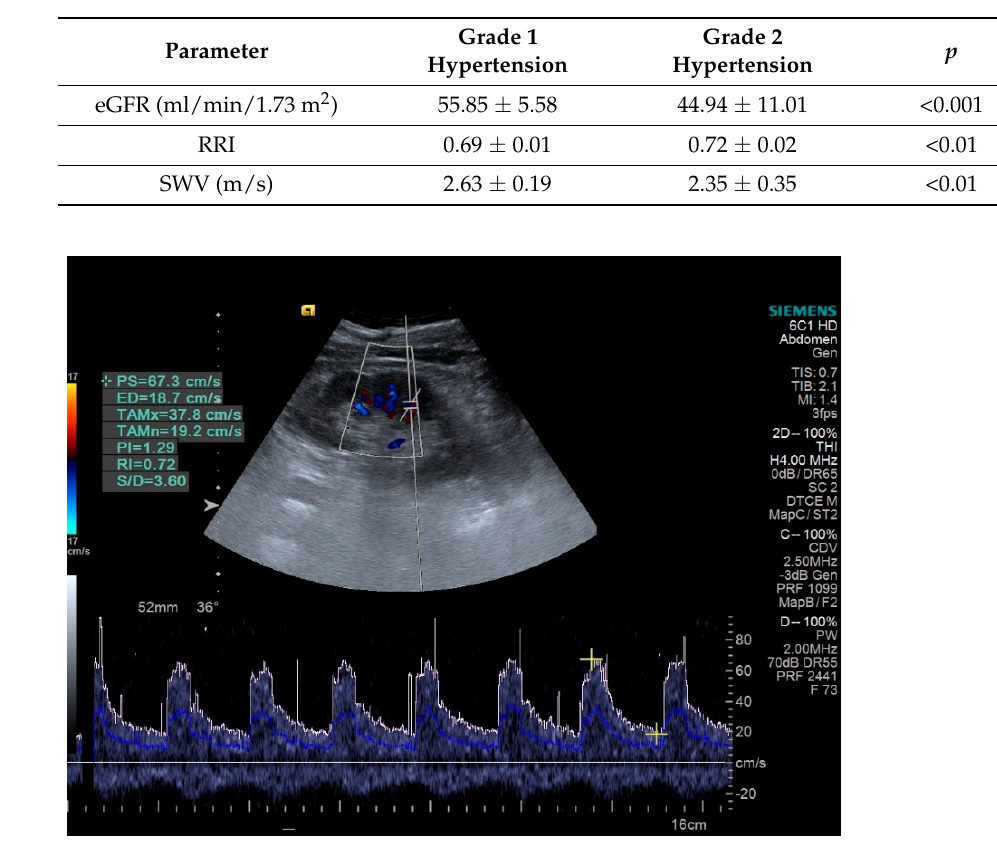
Figure 1. Interlobar renal artery (RRI = 0.72).